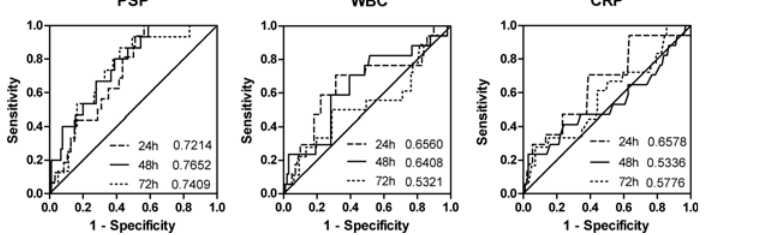
Fig 6. Receiver operating characteristics curve to predict infection for PSP (A), CRP (B) and WBC (C) at postoperative 1 – 3. A cutoff of 48.1 ng/ml for PSP levels at postoperative day 2 reveals a sensitivity of 64% and a specificity of 70%. PLR (positive likelihood ratio) = 2.1. NLR (negative likelihood ratio) = 0.51.